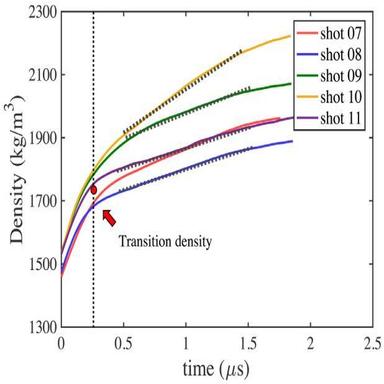
Compressibility of granular material: history evolution of density.